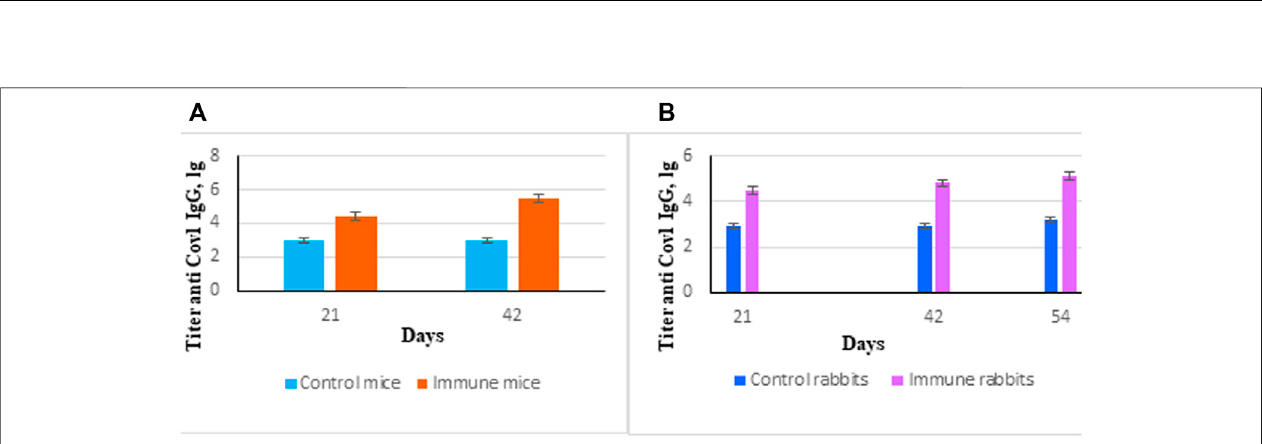
FIGURE 3 | Immune response induced by immunization of animals with recombinant protein SarsS. (A) Mice (n (cid:1) 10) were immunized twice subcutaneously with the recombinantprotein SarsStogether withaluminumhydroxide asadjuvant.Controlmice (n (cid:1) 10)receivedaluminumhydrochlorideasanadjuvant.Antibodytiter was determinedbyELISAasdescribedin WesternBlotting . (B) Rabbits(n (cid:1) 3)wereimmunizedthreetimessubcutaneouslywiththerecombinantproteinSarsStogetherwith aluminum hydroxide as vaccine adjuvant. Control rabbits (n (cid:1) 2) received aluminum hydrochloride as an adjuvant. Antibody titer was determined by ELISA as described in ELISA Assay . Reciprocal antibody titers were characterized as log10 (ELISA) and presented as mean ± SEM. The p -values are obtained after comparison with control animals. Data were analyzed using the Student ’ s t-test * - p < 0.05.